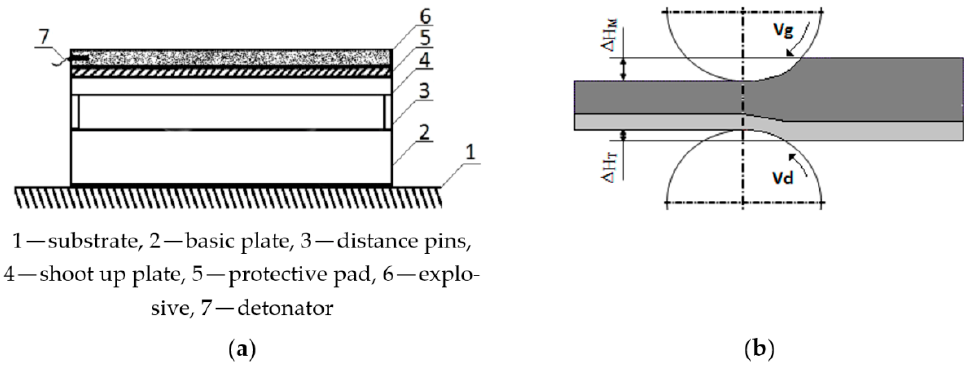
Figure 2. Stages of production of bimetallic plates, ( a ) combining by the method of explosive welding ( b ) scheme of asymmetrical rolling of bimetallic plates based on [3,17,19,29].